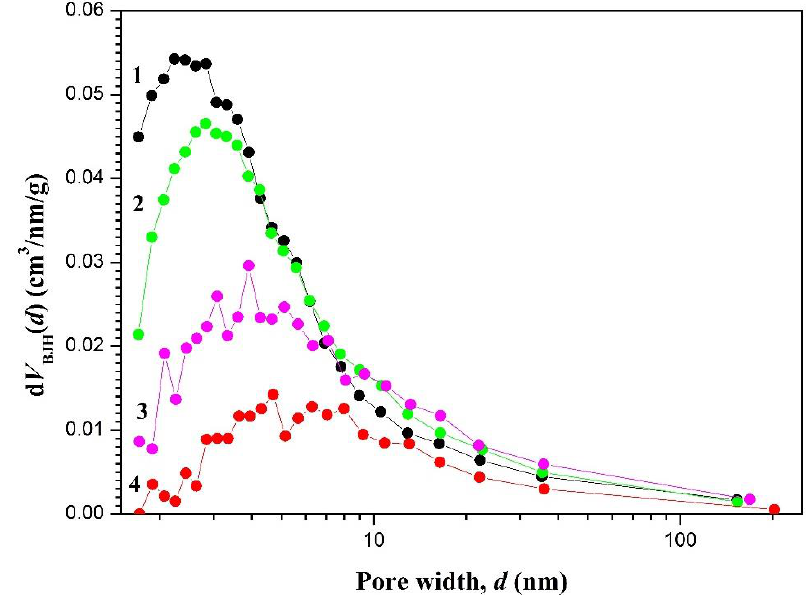
Figure 5. Pore size distributions d V( D ), obtained from the analysis of adsorption isotherms using the Barrett-Joyner-Halenda (BJH) model, for supercritically dried native NGF (1) and BC samples after the biodegradation by cellobiohydrolase from S. candidum 3C for 120 (2), 240 (3) minutes, 24 h (4). Table 1. Texture parameters of supercritically dried native NGF and CBHSc–treated BC samples. Time t